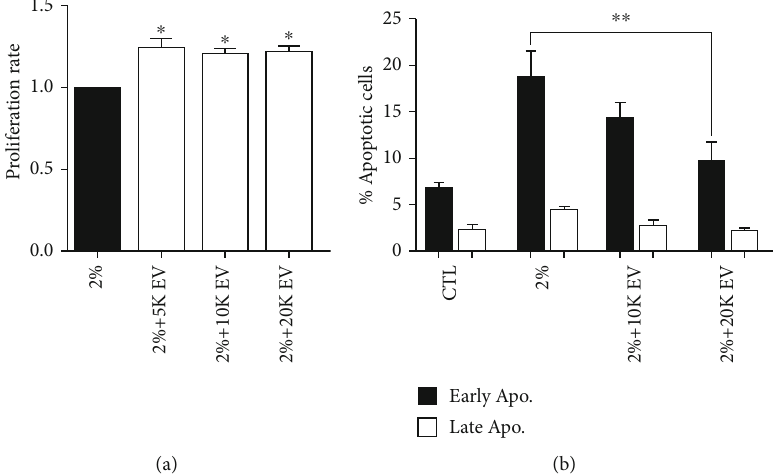
Figure 4: Proliferation and apoptosis of HCECs in damage conditions, treated with di ff erent doses of MSC-EVs. (a). Proliferation levels of HCECs maintained in 2% FBS for 24 hours and treated for further 24 hours with di ff erent doses of MSC-EVs ( 5 ‐ 20 × 10 3 MSC-EV/cell). Data are represented as mean ± SD of four independent experiments normalized to CTL. (b). Percentage of early apoptotic (black columns) and late apoptotic (grey column) HCECs cultured either in ENDOGRO 10% (CTL) or in 2% FBS for 24 hours (2%) and treated for further 24 hours with di ff erent doses of MSC-EVs (10 and 20 × 10 3 MSC-EV/cell). One-way ANOVA analysis with Tukey ’ s multicomparison test was performed among 2% FBS alone and 2 % + EVs ( ∗ p < 0 : 05 , ∗∗ p < 0 : 001